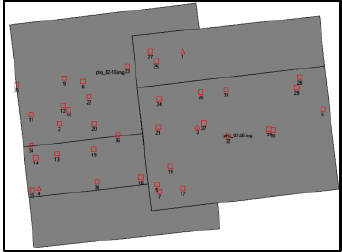
Figure 2. Layout of the sub block that was extracted from the first